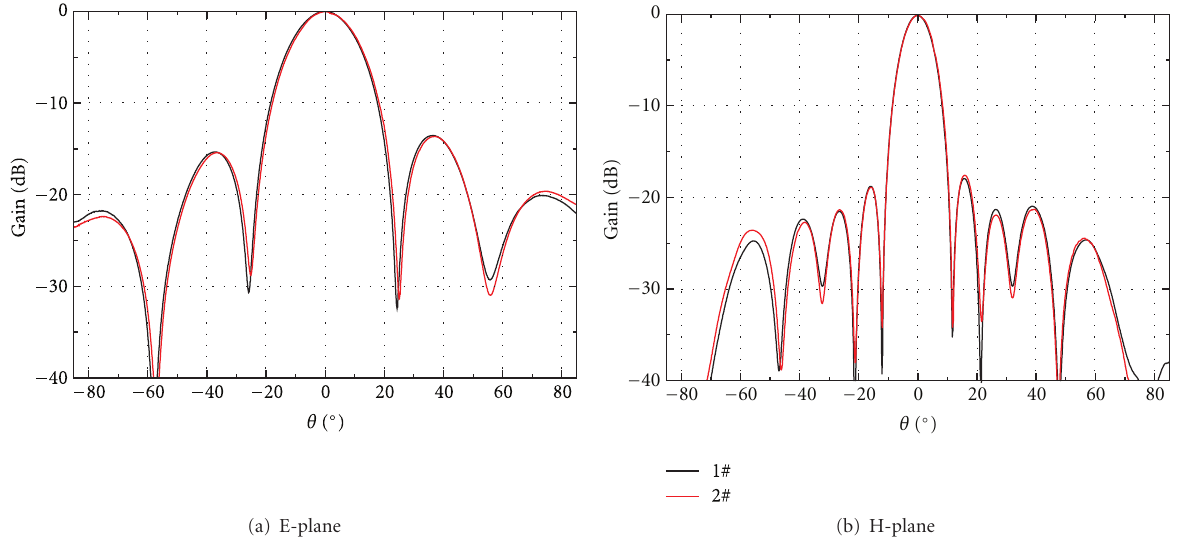
Figure 14: The radiation pattern of the high integrate broad-band microstrip antenna array using MPCB technology at the center frequency.